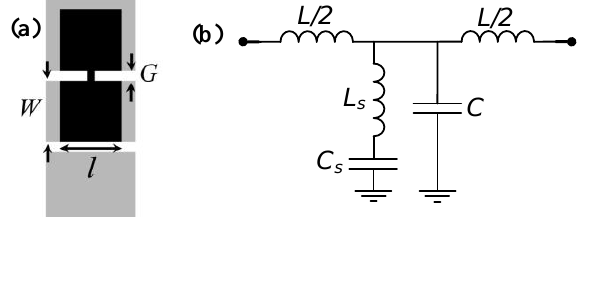
Figure 15. Typical layout of a SIR-loaded CPW ( a ) and equivalent circuit model ( b ).